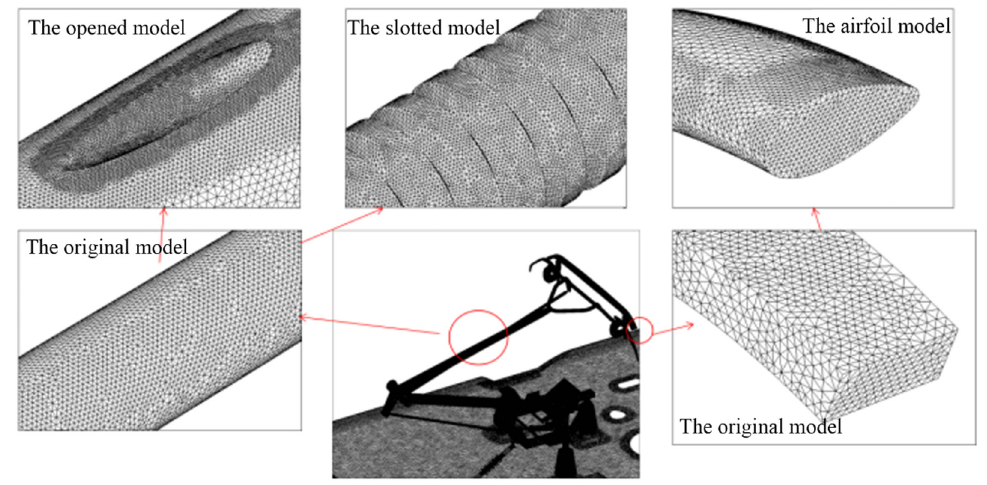
Figure 3. Schematic diagram of the calculation grid.